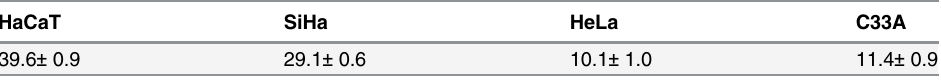
Table 3. Specific activity of Gly-Pro-p-nitroanilide hydrolysis in room temperature, pH = 8.0, in the supernatant of adherent cells.